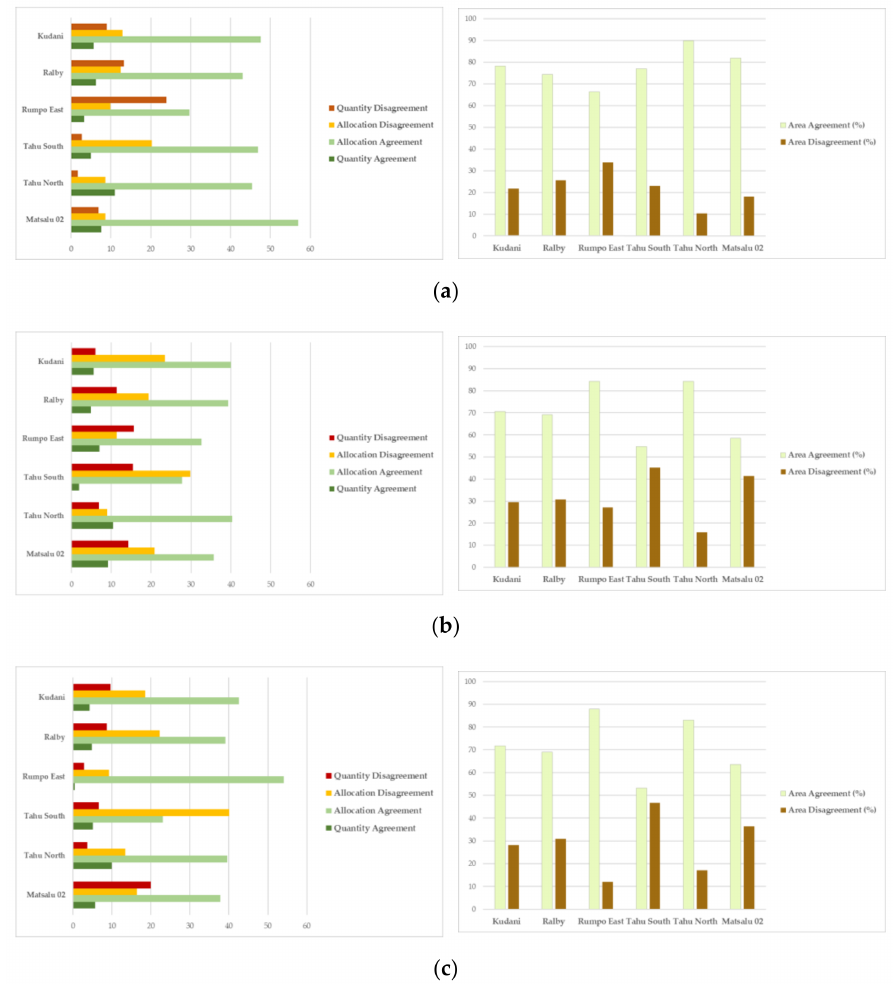
Figure 6. Comparisons between classifiers using the parameters of Quantity Disagreement, Al- location Disagreement, Allocation Agreement and Quantity Agreement (left) and agreement and disagreement areas (right). ( a ) RF OBIA and PBIA, ( b ) RF and KNN PBIA, ( c ) RF and KNN OBIA. The categories that were mixed in the disagreement areas in the study areas the most were: KUD (38% from US to TG), RAL (45% from TG to US), RUE (27% from OP to US) and TAN (42% from LS to US and 37% from US to LS). In TAS and MA2, the mixture is due to more than two categories (Figure